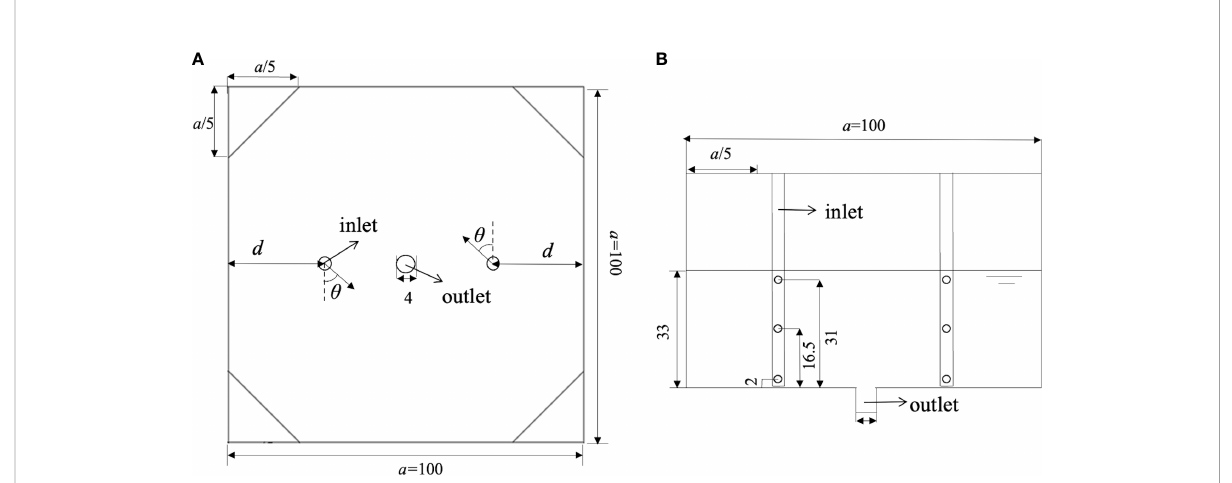
FIGURE 2 Con fi guration of the octagonal aquaculture tank: (A) Top view; (B) Front view (Unite: cm).